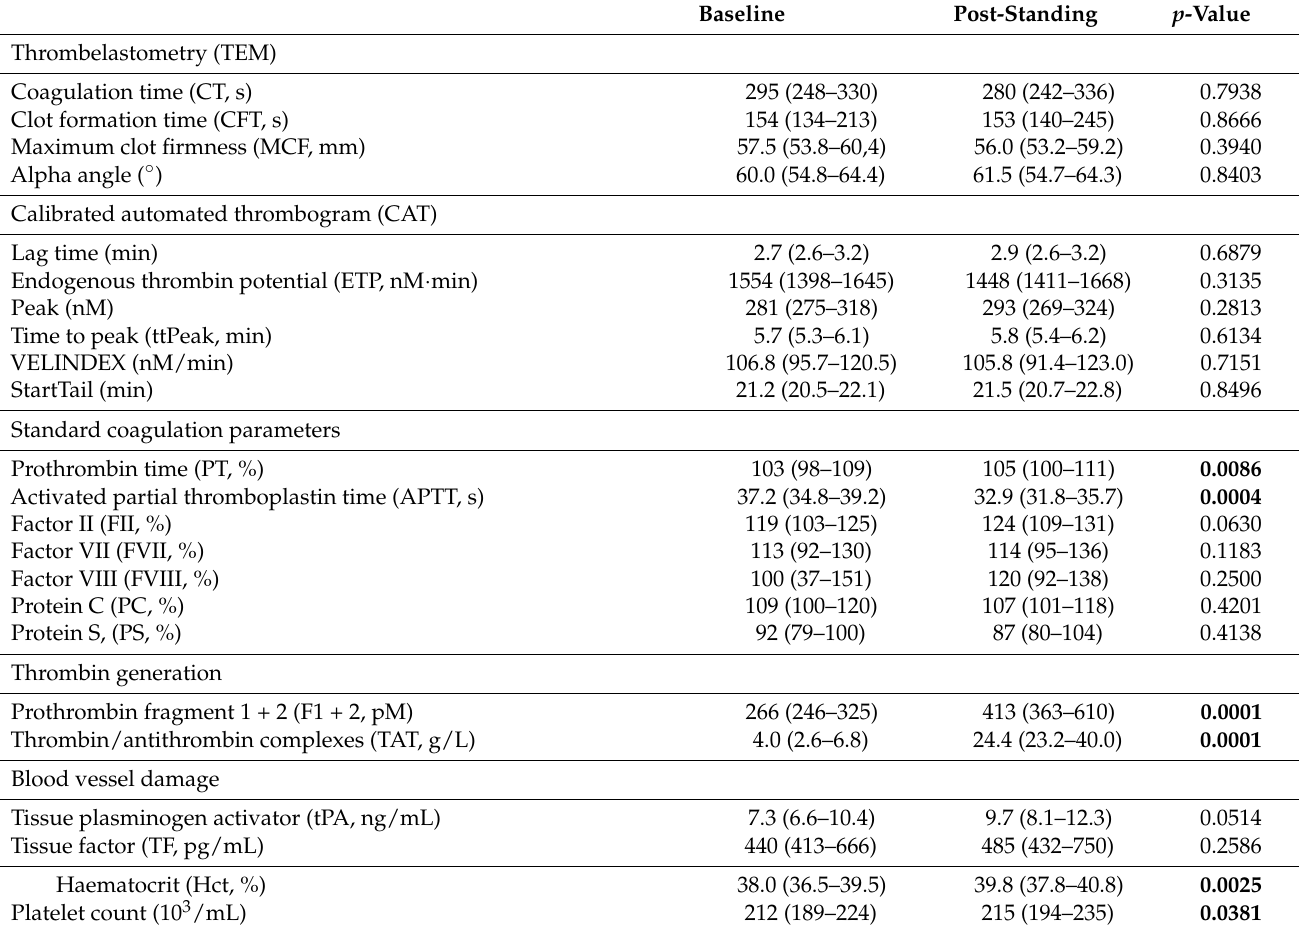
Table 4. Effect of orthostatic challenge on coagulation values in older participants (n = 22). Data are expressed as median ± 95% CI. p -values were calculated by means of the Wilcoxon matched pairs signed-rank